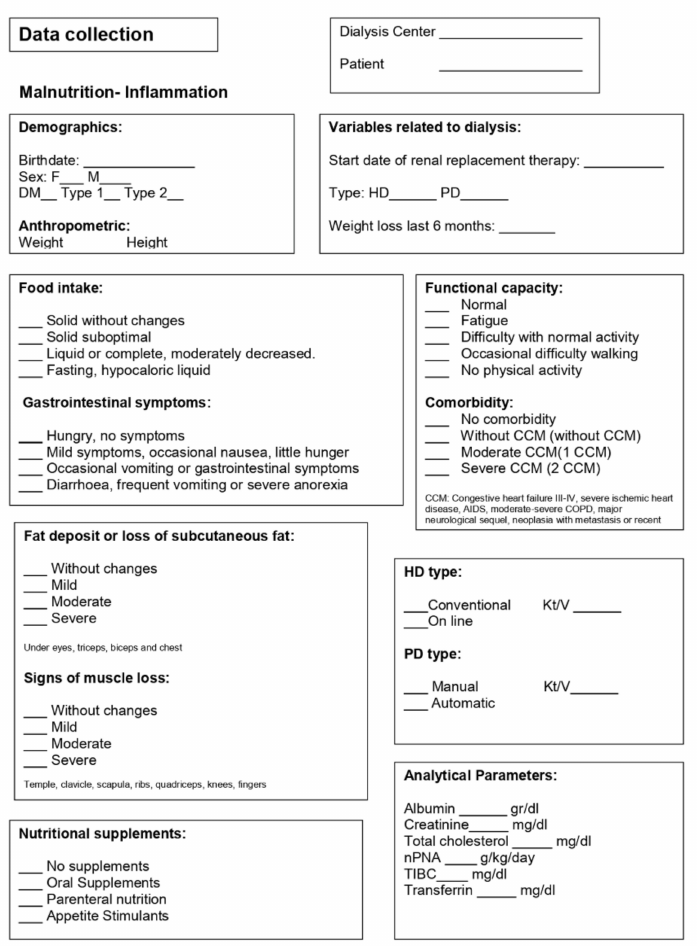
Figure 1. Data collection